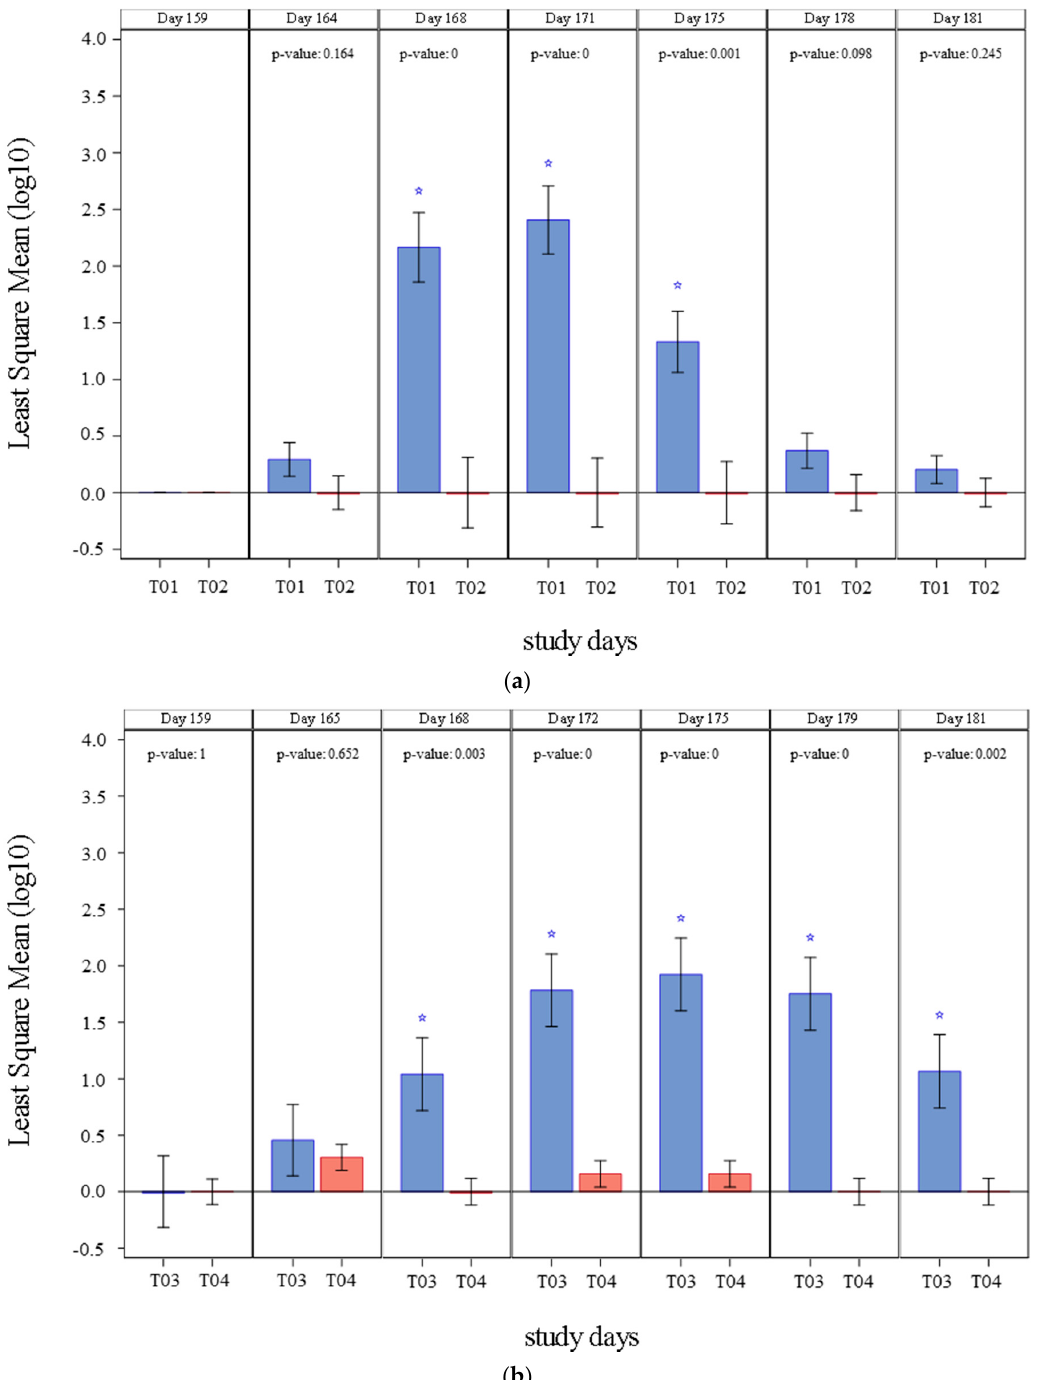
Figure 1. PCV2 viremia (Least Square Mean (log 10 ) of DNA copies/mL) by treatment and day of study and significance: ( a ) PCV2 viremia detected in study 1, results from T01 are represented in blue and results from T02 are represented in red. When p -value <0.0001 it is described as 0, and significant differences between groups ( p ≤ 0.05) are marked with a blue star; ( b ) PCV2 viremia detected in study 2, results from T03 are represented in blue and results from T04 are represented in red. When p -value <0.0001 it is described as 0, and significant differences between groups ( p ≤ 0.05) are marked with a blue star.